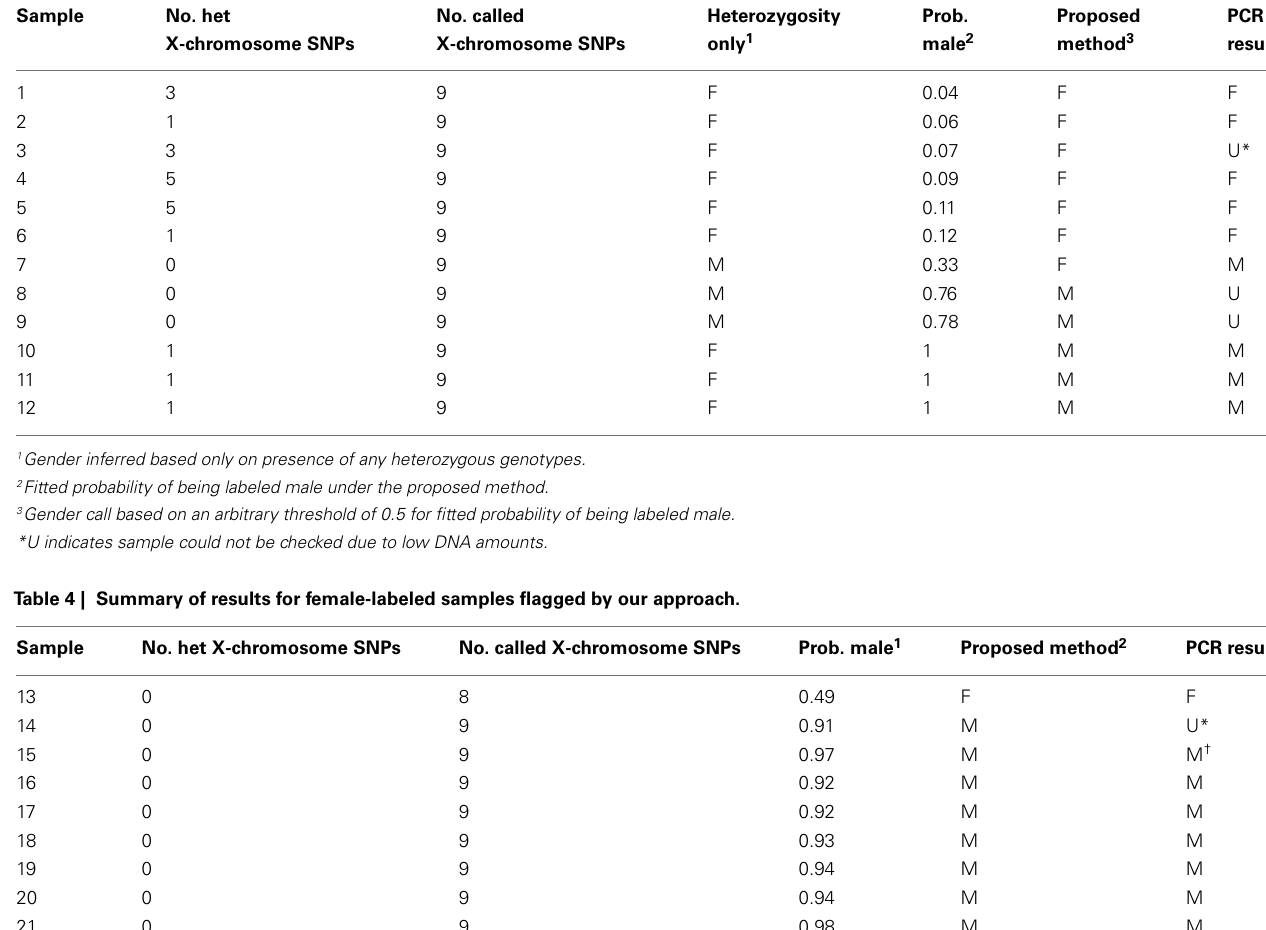
Table 3 | Summary of results for male-labeled samples flagged by our approach or by positive heterozygosity values. Sample